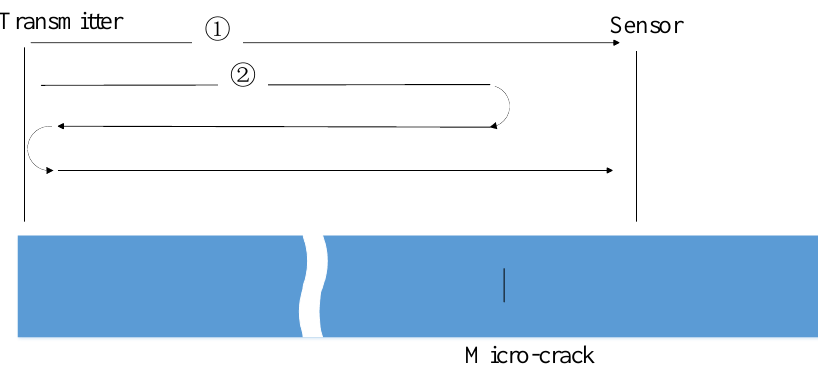
Figure 12. The propagation wave path for the time-domain signal received from the micro-cracked plate with a micro-crack 6 nm wide and 800 μm